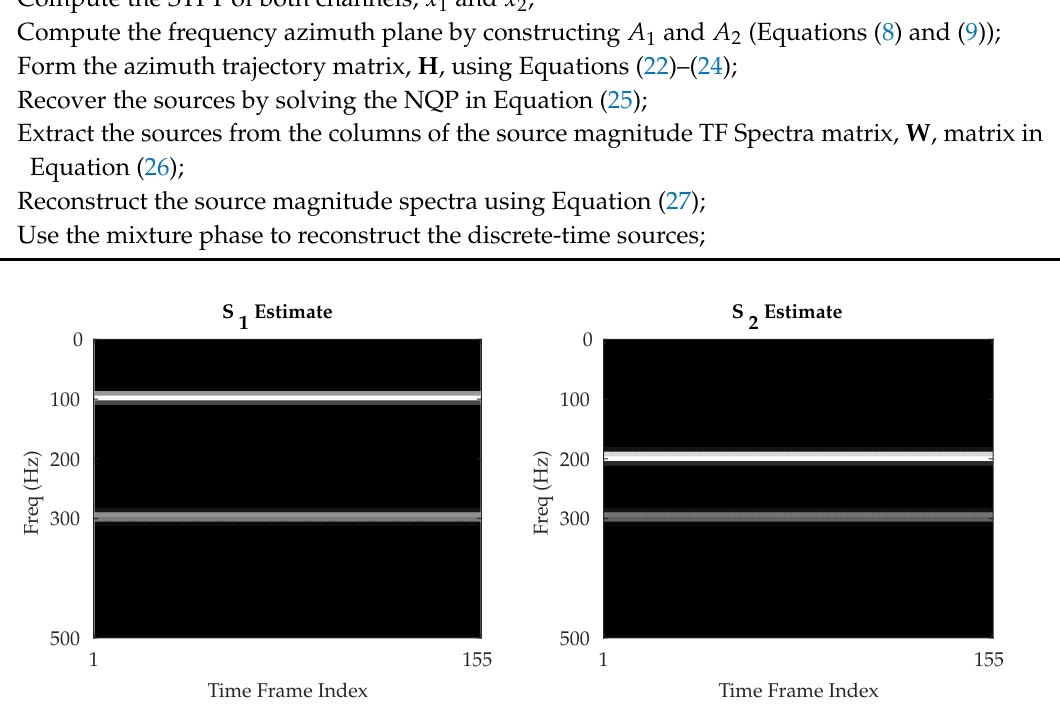
Figure 5. Reconstruction using Redress: both of the estimates, S 1 ( f ) and S 2 ( f ) , have non-zero magnitudes at 300 Hz.